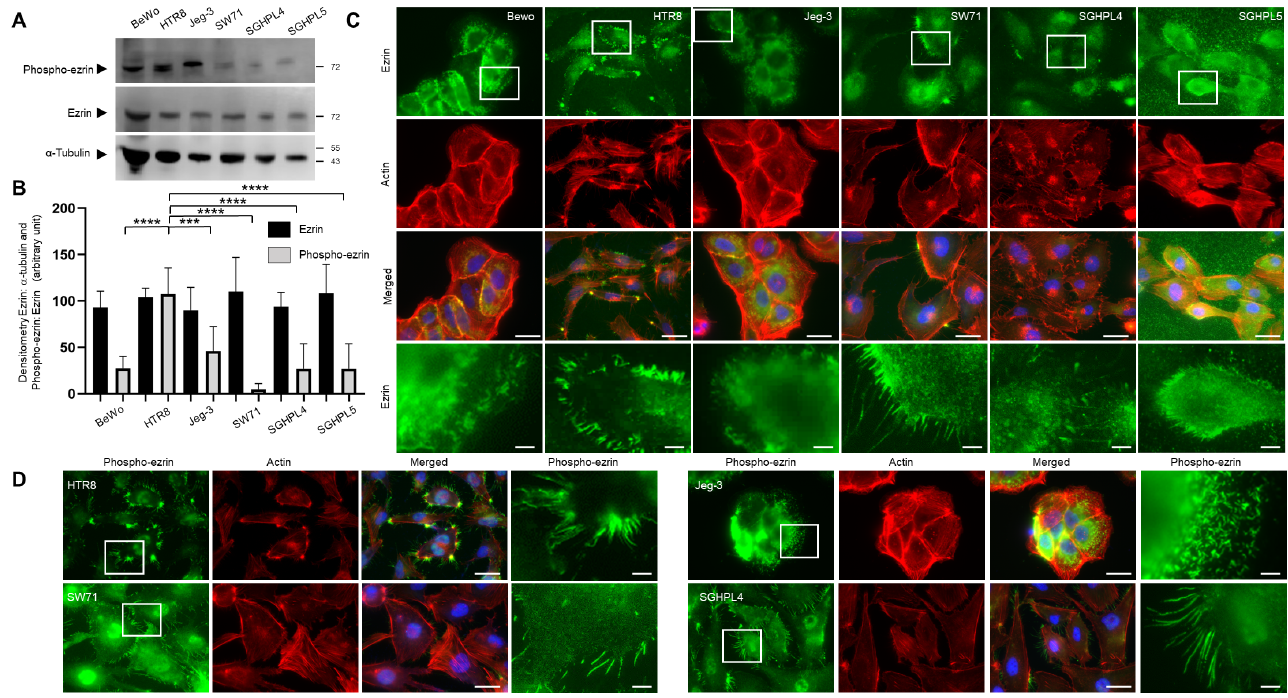
Figure 2. Ezrin is expressed in all trophoblast cell lines. Choriocarcinoma cells BeWo and Jeg-3 cells, along with EVT cell lines HTR8/SVneo, Swan71, SGHPL4, and SGHPL5 cells, were grown for 48 h prior to the collection of the protein lysates for Western blotting ( A ) or cell staining ( C , D ). Cells were collected and solubilised in Lammeli buffer and equal loadings were separated by SDS-PAGE electrophoresis. Western blotting was carried out and membranes were probed for ezrin, phosphor- ezrin Thr567, or α -tubulin and cropped images are presented ( A ). The expression levels of ezrin and phospho-ezrin Thr567 were measured by densitometric analysis, normalised to α -tubulin and ezrin, respectively, and presented as arbitrary units and as mean values ± SD of 3 independent samples. *** p < 0.001 or **** p < 0.0001 (one-way ANOVA) ( B ). For immunostaining, BeWo and Jeg-3 cells and EVT-like cell lines HTR8 SV/Neo, Swan71, SGHPL4, and SGHPL5 cells were seeded on fibronectin-coated coverslips and grown for 48 h prior to fixation, permeabilisation, and staining for ezrin ( C ), phospho-ezrin Thr567 ( D ), and actin ( C , D ). Cells were mounted and viewed using epifluorescence microscopy. Images in the last row correspond to the enlarged regions of the highlighted cells. Bar corresponds to 25 µ m in the wide views and 5 µ m in the zoomed-in regions. Given that HTR8/SV neo and Swan71 cells are some of the best-characterised EVT models and given the significant differences between the levels or localisation of both ezrin and its phosphorylated Thr567 state in these two cells, we decided to use both lines for further